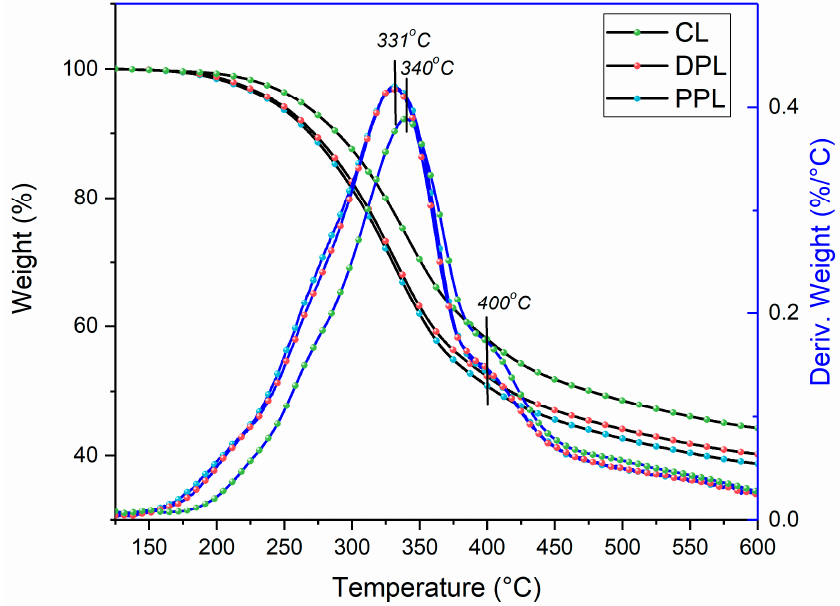
Figure 6. Thermogravimetric curves and derivative thermogravimetry curves of CL, DPL and PPL.